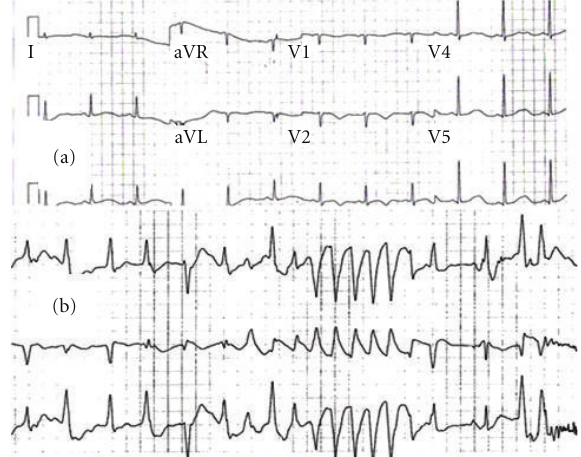
Figure 2: (a) ECG after cardiac arrest: Sinus rhythm (68 bpm), QTc 683ms. (b) Self-terminated episodes of TdP.